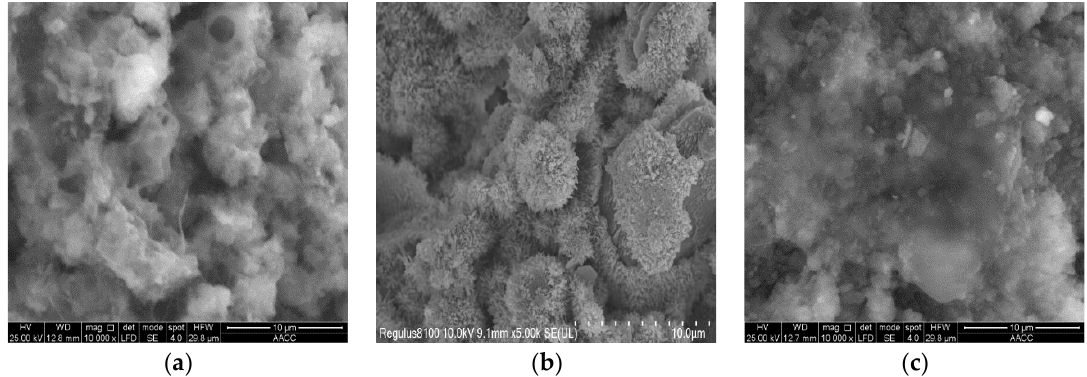
Figure 3. Cement-based materials of different admixtures. Reprinted from Ref. [19]. ( a ). Pure cement-based materials. ( b ). Cement-based materials with nano-SiO 2 powder. ( c ). Cement-based materials with internal nano-SiO 2 production.